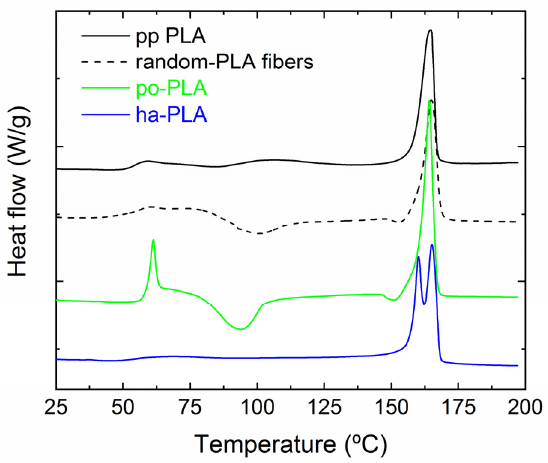
Figure 8. Differential scanning calorimetry (DSC) heating curves of pp-PLA, random-PLA fibers, partially oriented (po-PLA) and highly oriented fibers (ha-PLA) at a heating rate of 10 °C/min. Table 3. Temperatures of glass transition (T g ), cold crystallization (T cc ), melting (T m ) and crystallinity percentage (cid:1850)(cid:1855) of samples. Errors in T ± 1 °C.